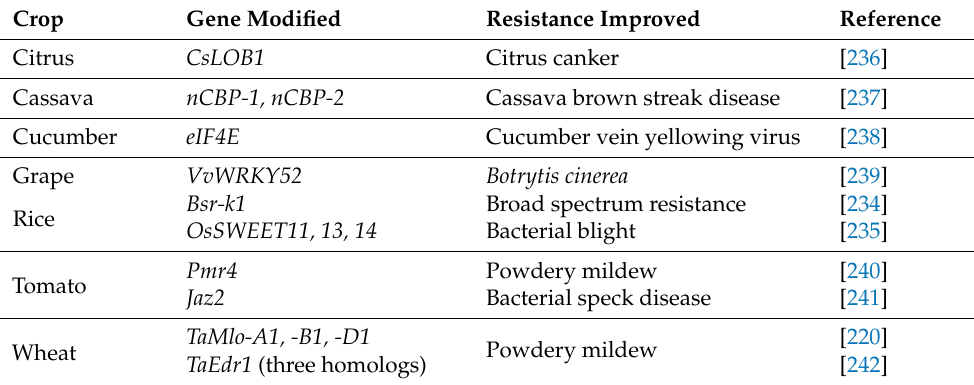
Table 3. CRISPR-Cas edited improvement of crops for disease